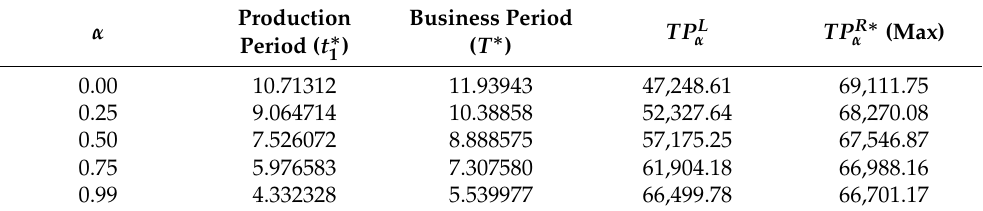
Table 3. Optimum results of Example 1 for maximizing TP R α .